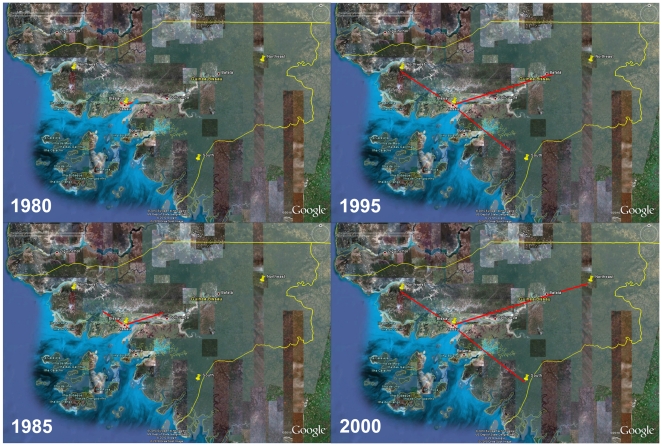
Temporal dynamics of spatial HIV-1 CRF02_AG diffusion within Guinea-Bissau.Snapshots of the HIV-1 CRF02_AG dispersal pattern within Guinea-Bissau. Lines between locations represent branches in the maximum clade credibility tree (MCC) along which well-supported location transitions occurs. The diffusion process was visualized in Google Earth (http://earth.google.com).